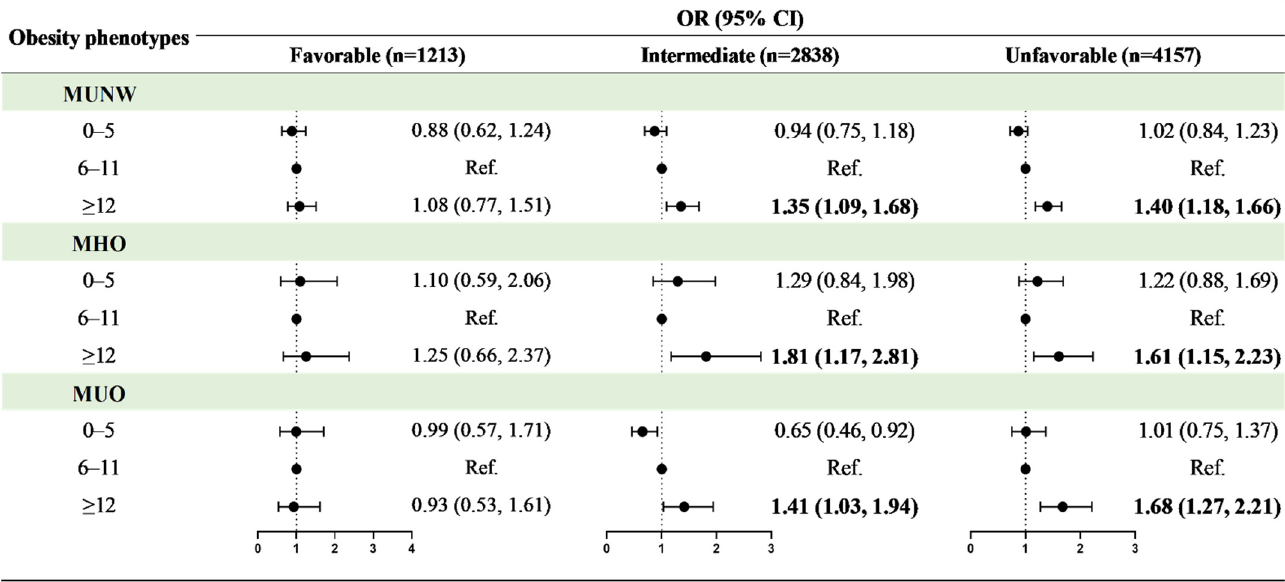
Figure 3. Associations between breastfeeding duration and obesity phenotypes in different healthy lifestyle groups. Obesity phenotypes include metabolic healthy normal weight (MHNW, reference group), metabolic unhealthy normal weight (MUNW), metabolic healthy obesity (MHO), and metabolic unhealthy obesity (MUO). Adjusted for age, sex, residence, single-child status, delivery model, delivery date, birth weight, family history of diseases (obesity, hypertension, diabetes mellitus and cerebrovascular disease), parental education level, parental tobacco and alcohol consumption, maternal age at delivery, and family household income. Bold values of OR (95% CI) are statistically significant ( p < 0.05).